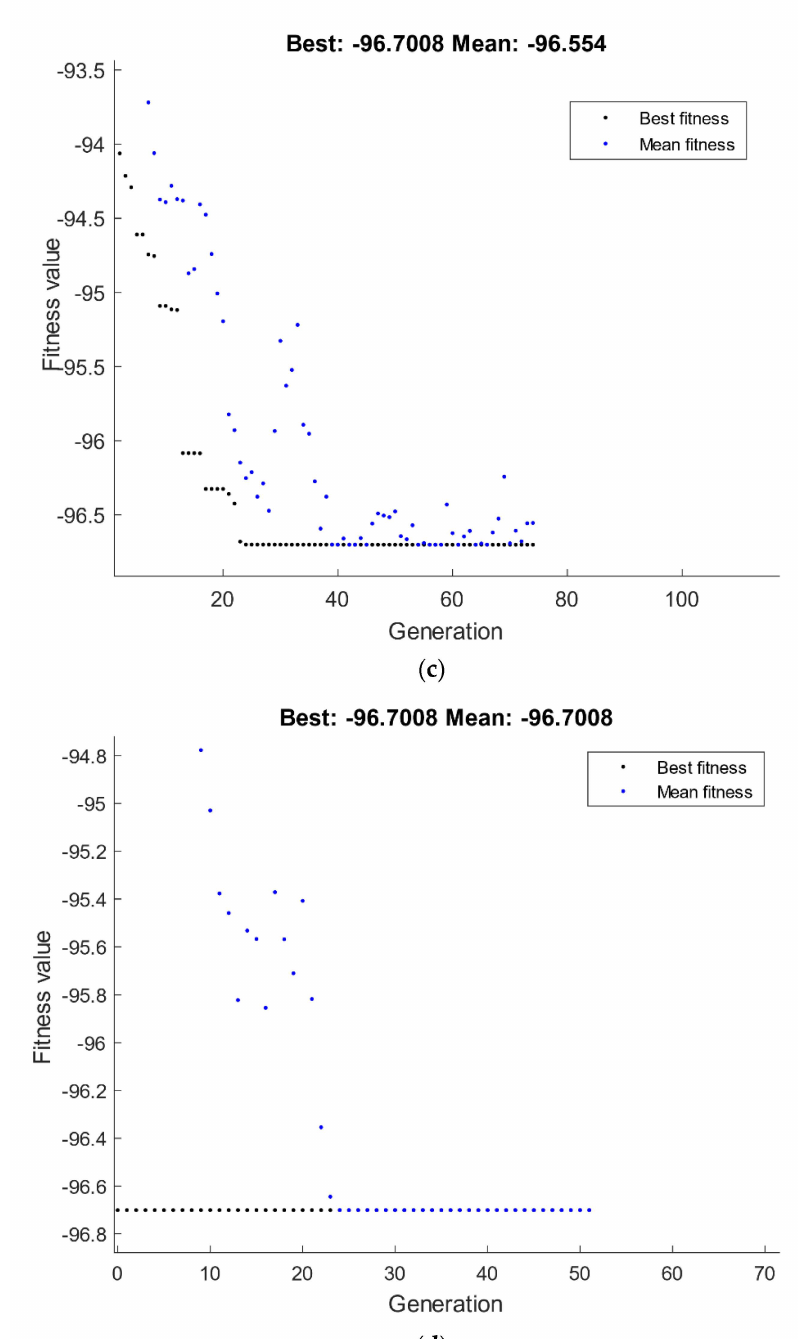
Figure 14. Optimum hardness at center ( a , b ) and edge ( c , d ) by GA ( a , c ) and hybrid RSM-GA ( b , d